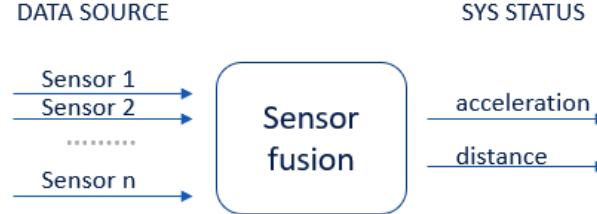
Figure 8. Fusion of data from different sensors.